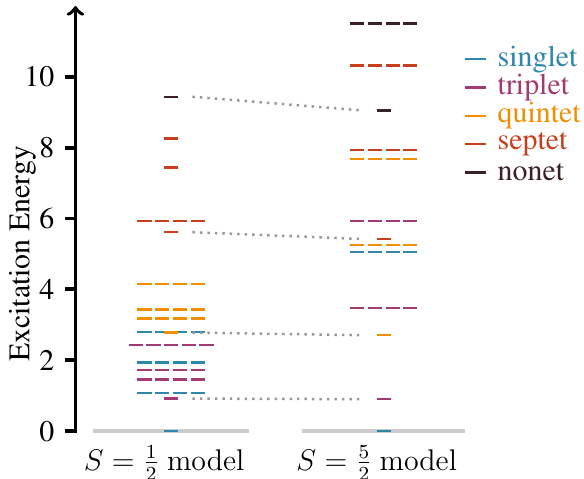
FIG. 7. The spectra of the S = 1 / 2 and S = 5 / 2 Heisenberg models for the P and/or Fe-Mo–cofactor cluster.